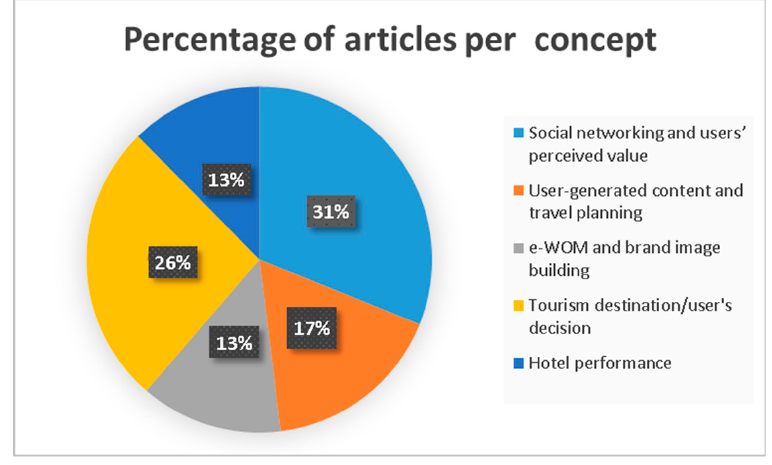
Figure 6. Percentage of articles per concept.